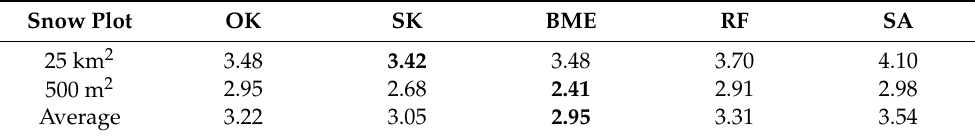
Table 3. RMSE of five upscaling results for two ground observation scales (unit: cm). Snow Plot OK